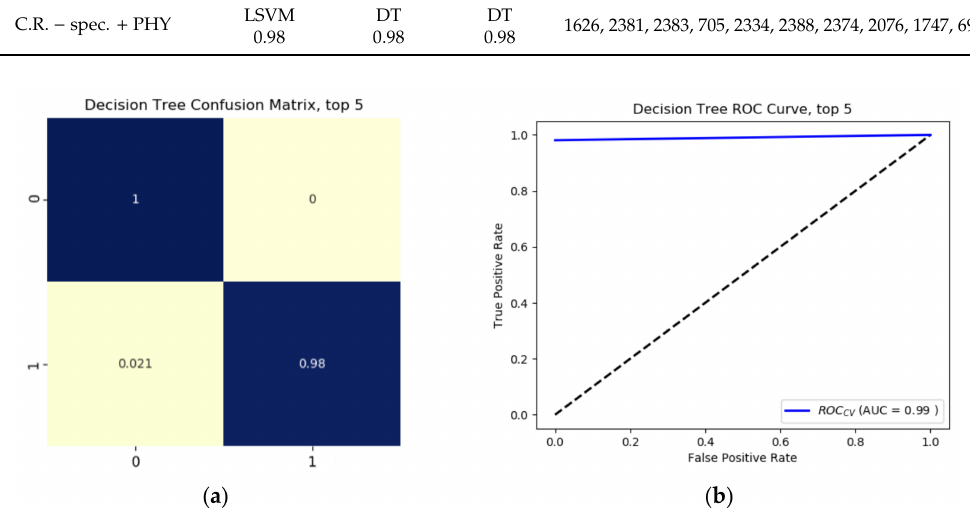
Figure 9. Flowering binary classification for [CR-spec] data: ( a ) confusion matrix class 0 representing non-flowering, and class 1 indicating flowering, ( b ) ROC